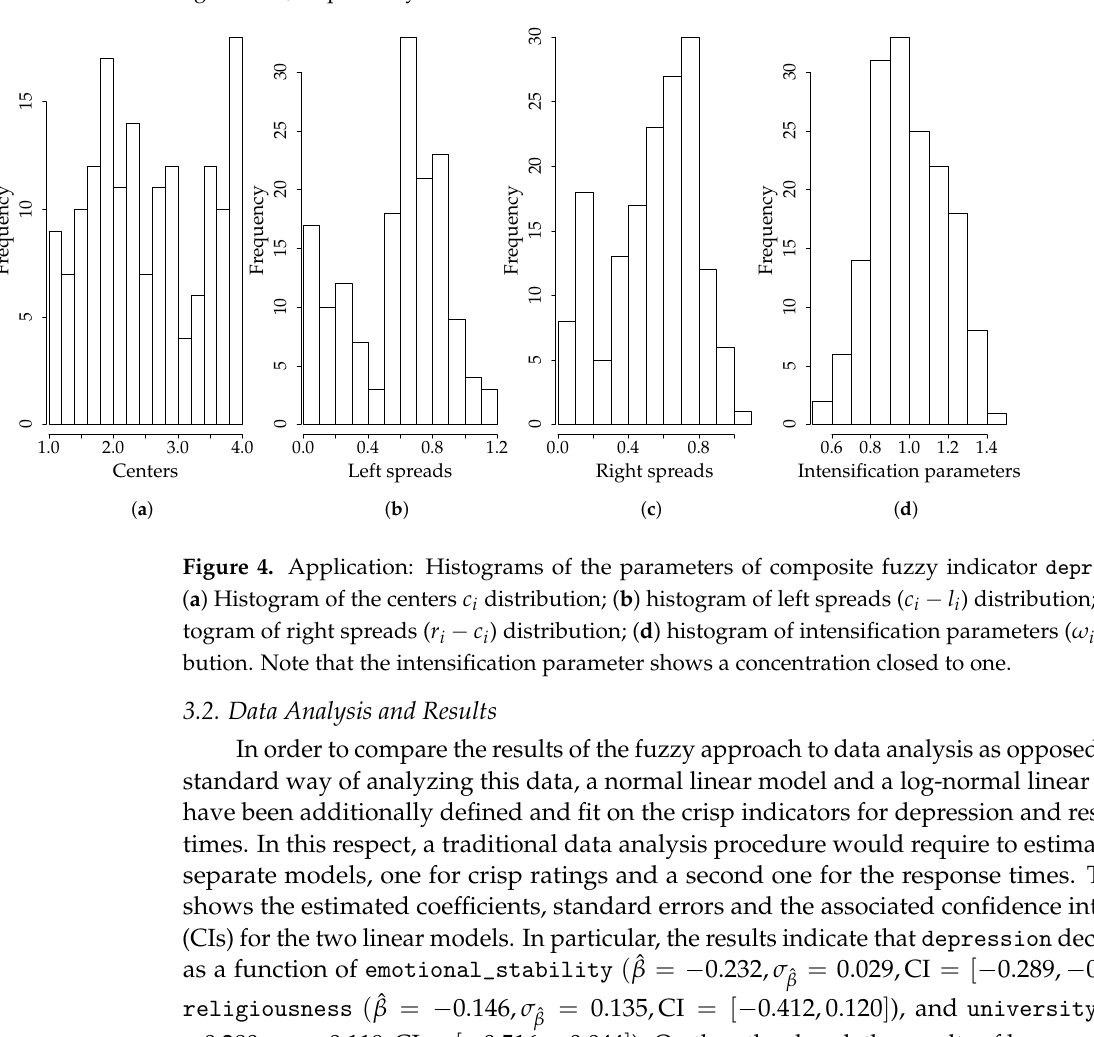
Figure 4. Application : Linear decision tree for the four response categories. Note that A , M , E Figure 3. Application: Linear decision tree for the four response categories. Note that A , M , and E denote the decision nodes of disagreement, moderate agreement/disagreement, and extreme denote the decision nodes of disagreement, moderate agreement/disagreement, extreme agreement, agreement, respectively. respectively.